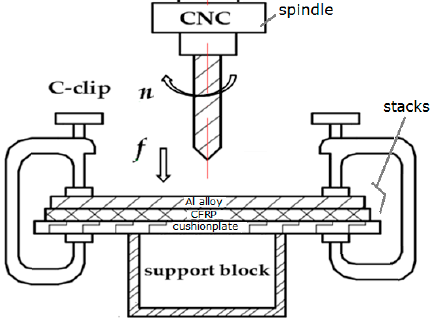
Figure 1. The manufacturing schematic.